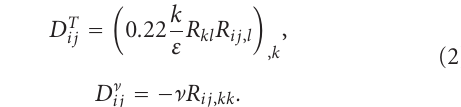
flow configurations, while the usual k - (cid:2) model, which is blind to any rotation e ff ect presents serious